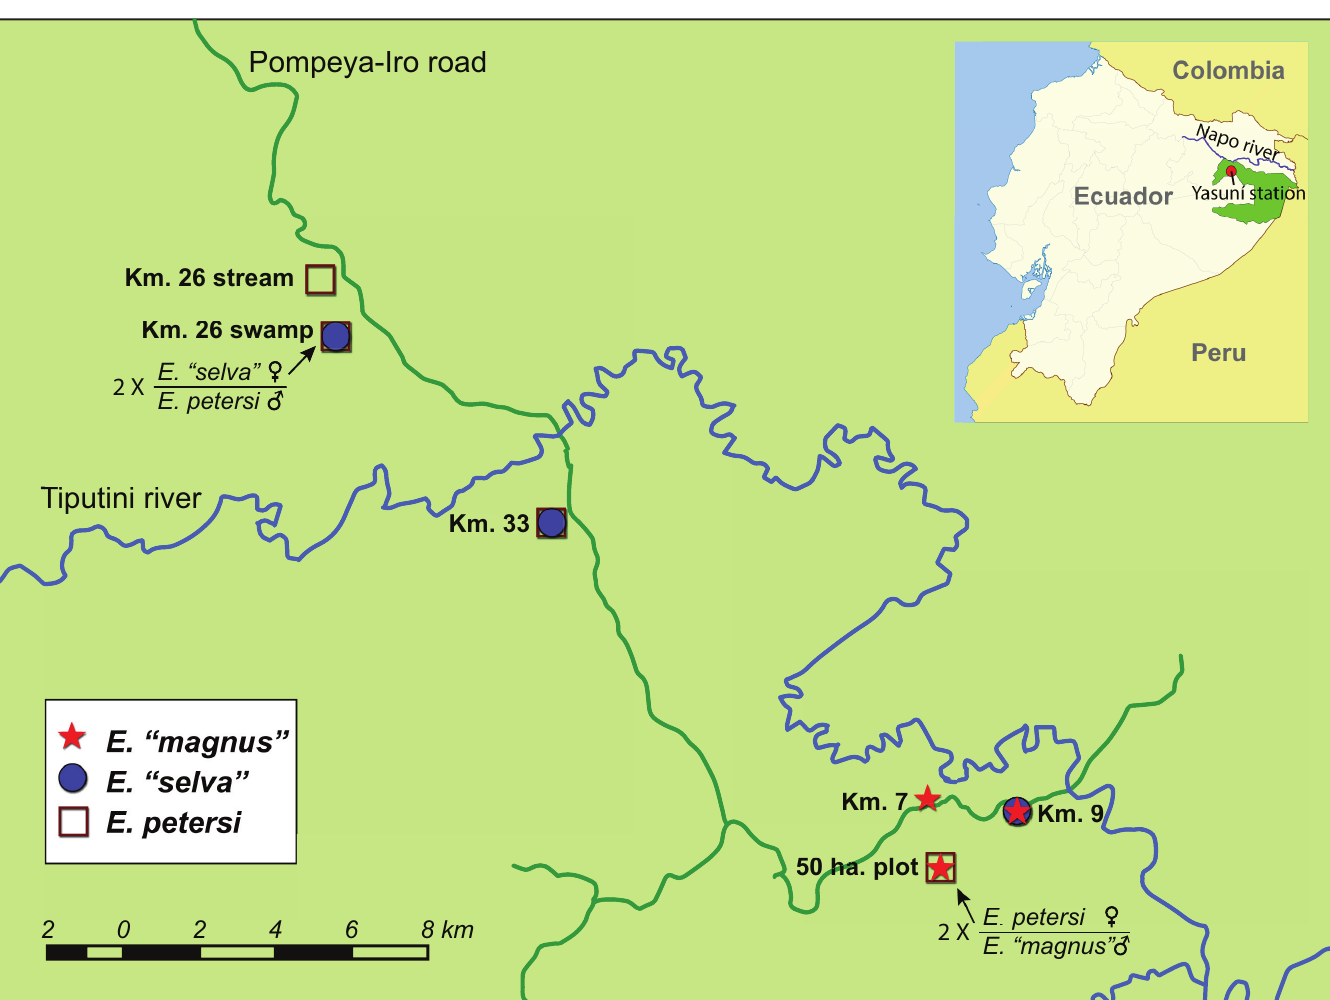
Fig 2. Map of sampling sites at Yasunı´National Park. Star symbols indicatepresence of E . “magnus” , circles indicatepresence of E . “selva” , and squares indicatepresenceof E . petersi . Sites with hybridpairs are shown with an arrow. compared to conspecific crosses (least square mean fertilization rate ± standard error for PM = 0.3 ± 0.17 and MS = 0.02 ± 0.15; planned contrasts for PM vs. conspecific: F P = 0.023, and MS vs. conspecific: F 1,27 = 18.95, P = 0.0002, Fig 3). However, E . “magnus” female- E . petersi male (MP) and E . “selva” female- E . “magnus” male (SM) crosses did not show any reduction in fertilization rate (least square mean fertilization rate ± standard error for MP = 0.46 ± 0.17, and SM = 0.81 ± 0.11; planned contrasts for MP vs. conspecific: F P = 0.126, and SM vs. conspecific: F 1,27 = 0.15, P = 0.705; Fig 3). Development and survival Heterospecific and conspecific crosses did not differ in the latency to hatch (generalized linear model with negative binomial distribution and log-link function, χ 2 = 0.2846, df = 2, P = 0.285). However, minimum time to metamorphosis was reduced in heterospecific crosses when com- pared to conspecific E . petersi crosses (mean time ± SD for heterospecific crosses = 51.34 ± 16.86 days; mean time ± SD for conspecific crosses = 76.89 ± 12.308 days; χ 2 = 4.39, df = 1, P = 0.036).